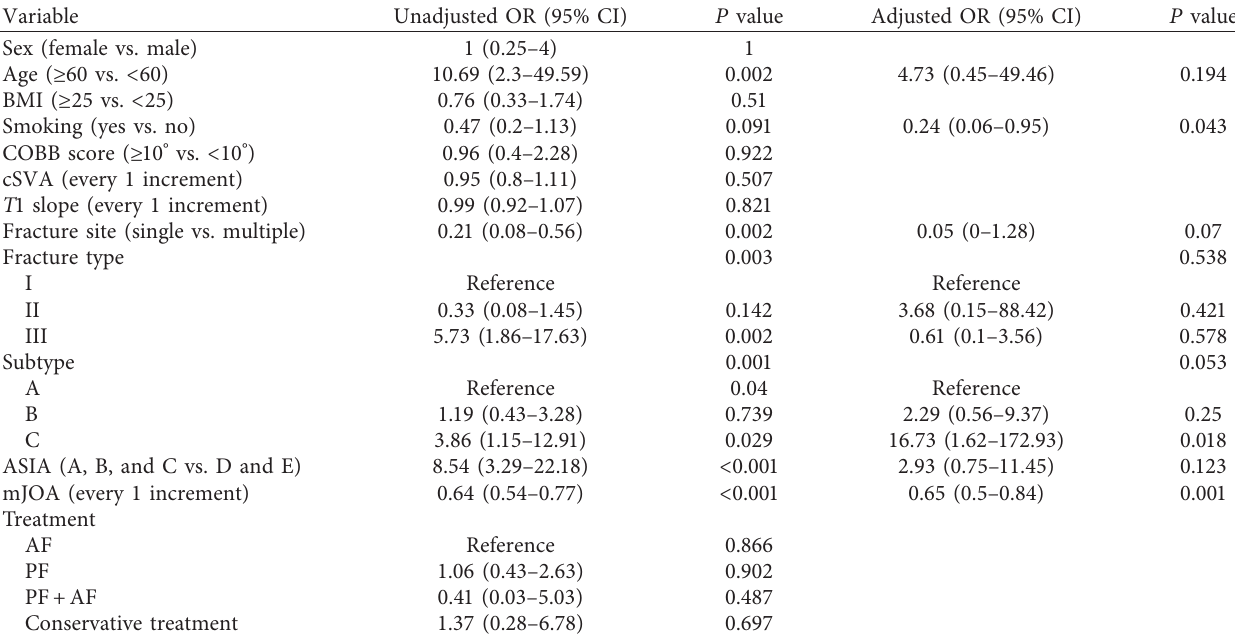
Table 3: Logistic and